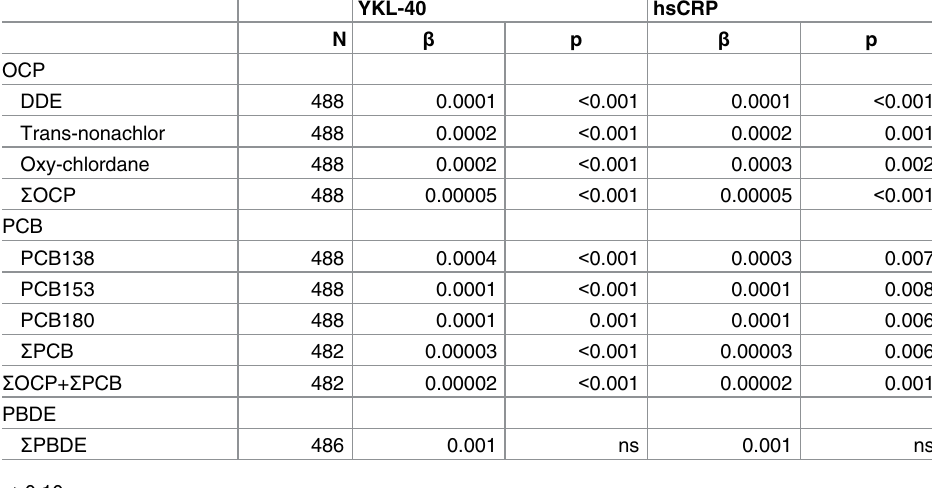
Table 6. Multivariate linear regression adjusting for age, alcohol intake, smoking, BMI and vitamin D on each POP individually or the sum of OCP, PCB, OCP+PCB and PBDE. YKL-40 hsCRP N β p β p OCP DDE 488 0.0001 < 0.001 0.0001 < 0.001 Trans-nonachlor 488 0.0002 < 0.001 0.0002 0.001 Oxy-chlordane 488 0.0002 < 0.001 0.0003 0.002 Σ OCP 488 0.00005 < 0.001 0.00005 < 0.001 PCB PCB138 488 0.0004 < 0.001 0.0003 0.007 PCB153 488 0.0001 < 0.001 0.0001 0.008 PCB180 488 0.0001 0.001 0.0001 Σ PCB 482 0.00003 < 0.001 0.00003 0.006 Σ OCP+ Σ PCB 482 0.00002 < 0.001 0.00002 0.001 PBDE Σ PBDE 486 0.001 ns 0.001 ns p >